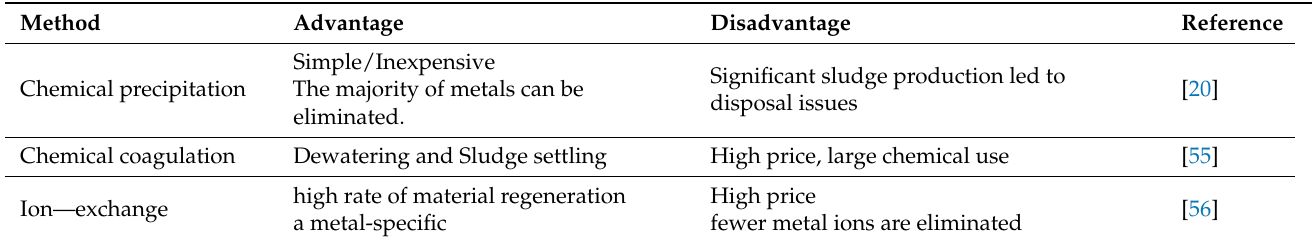
Table 4. Comparison of technologies for heavy metal removal from